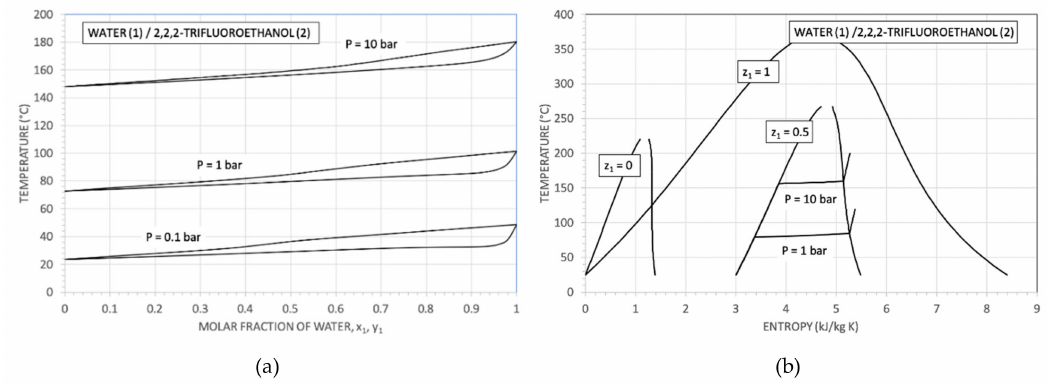
Figure 3. Water / 2,2,2-trifluoroethanol mixtures: ( a ) phase diagram T–xy, for 0.1, 1 and 10 bar; ( b ) saturation curves (bubble and dew lines) in the T–S plane for mixtures at di ff erent compositions.